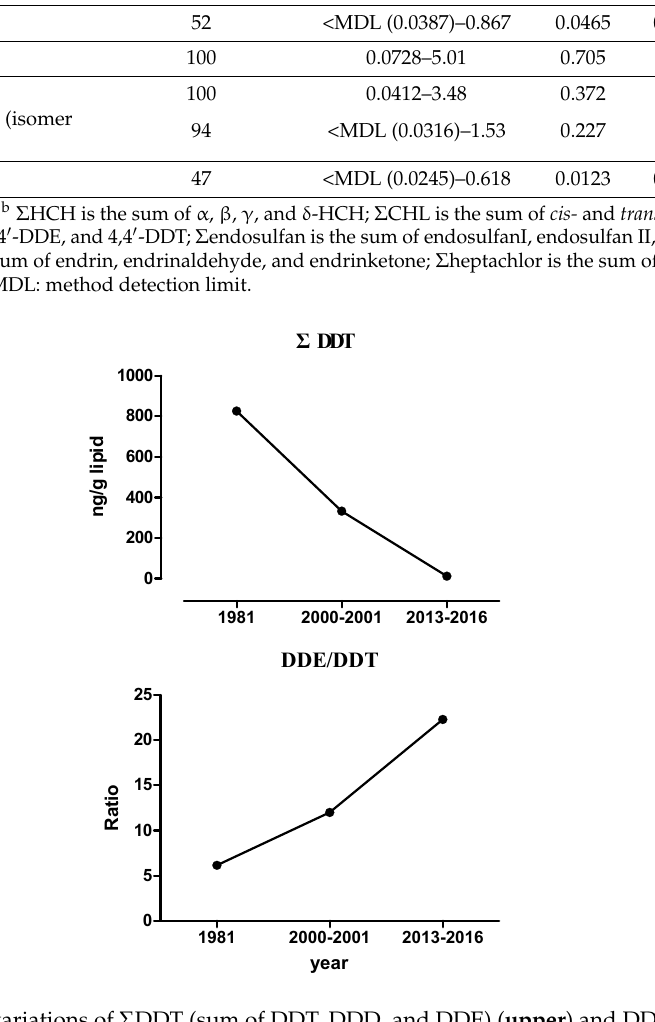
Figure 1. Trends in variations of Σ DDT (sum of DDT, DDD, and DDE) (upper) and DDE/DDT ratios (lower) in the breastmilk of Taiwanese women in 1981 and during 2000–2001 [18,19] and 2013–2016 (the present study).